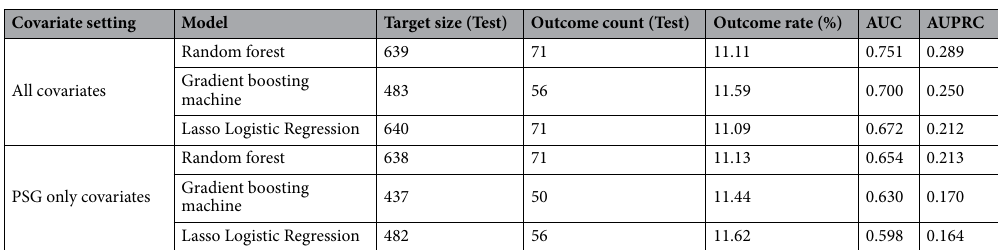
Table 3. Prediction model performance for test data set. All covariates setting used all OMOP CDM variables including polysomnography parameter concepts, and PSG only covariates used only gender, age group, and polysomnography parameter concepts for developing and training the prediction model. AUC area under the receiver operating characteristic curve, AUPRC area under the precision recall